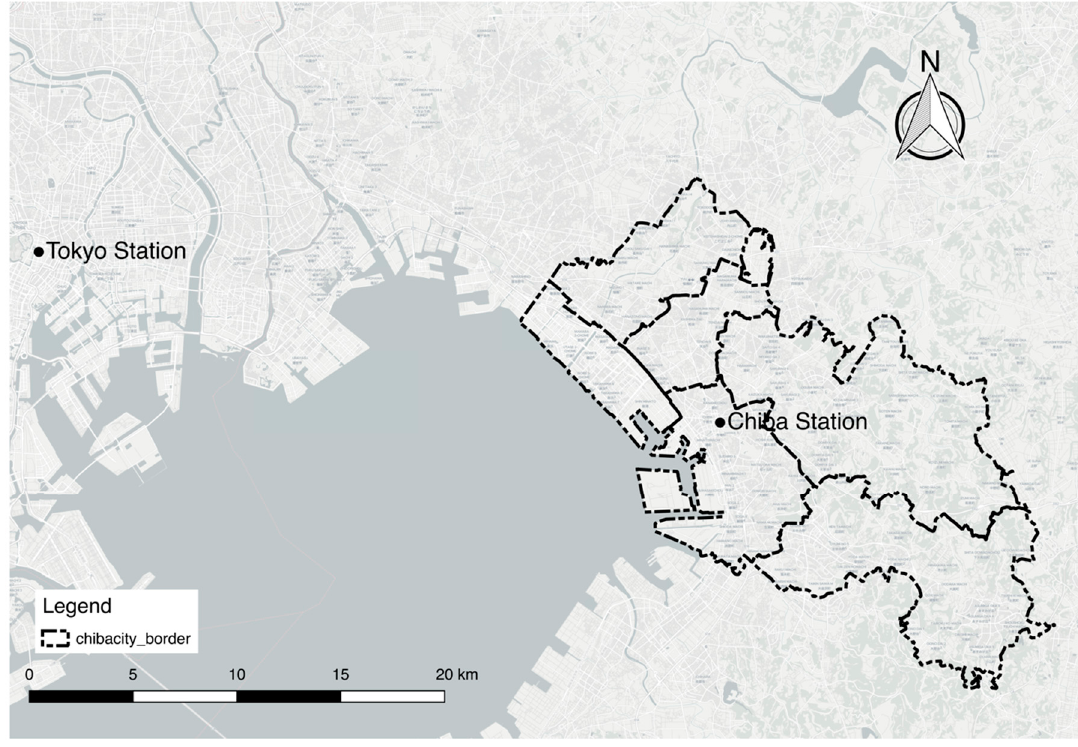
Figure 2. Chiba City study area.